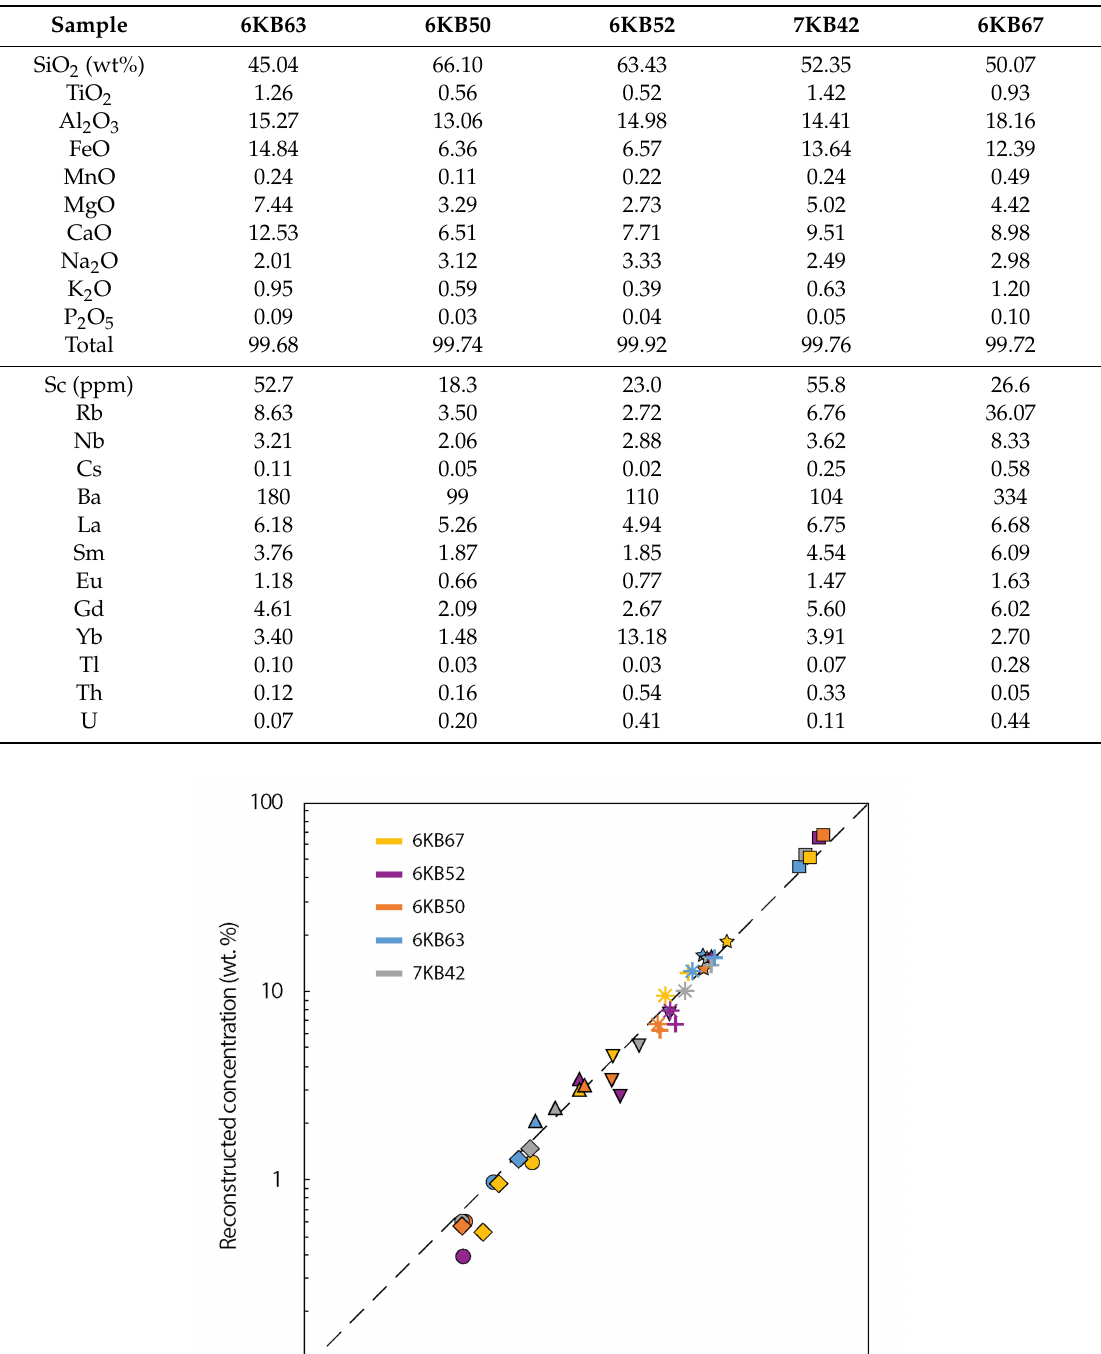
Table 3. Major (wt%) and trace element (ppm) concentrations of the KSZ samples obtained with the reconstitution approach.